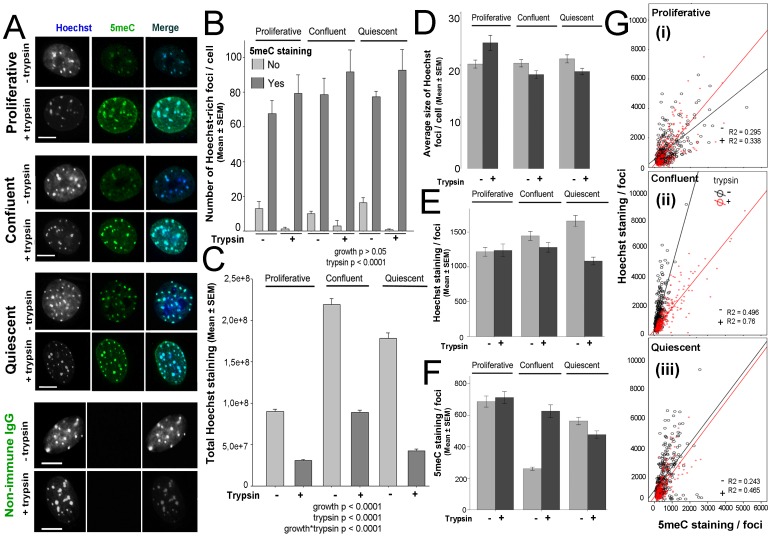
The effect of cell growth on the pattern of co-staining for 5meC and bisBenzimide (Hoechst).
A co-staining of 5meC and DNA by Hoechst in cells during proliferation after acid alone (−trypsin) or acid followed by trypsin (+trypsin). 5meC foci are co-localized with Hoechst-dense regions in each cell. Representative non-immune IgG staining in proliferative cells is also shown. Scale bar 10 µm. B The number of Hoechst-dense foci per cell co-stained with 5meC or failed to co-stain with trypsin (+) or without (−). Tryptic digestion significantly (p<0.0001) affected the detection of co-localization of 5meC and DNA-dense areas. C The level of Hoechst staining (arbitrary units of optical density) of cells with trypsin (+) or without (−) during proliferation. Trypsin revealed a decrease in the detection of amount of Hoechst staining in each cell (p<0.0001) and cell growth affected Hoechst staining (p<0.0001). D Average size of Hoechst-rich foci per cell (arbitrary units of optical density). E The level of Hoechst foci staining per cell. F The level of 5meC foci staining per cell. Trypsin decreased the detectable amount of Hoechst and 5meC foci (p<0.0001). Cell growth affected the 5meC (p<0.0001) but not Hoechst (p>0.05). G The relationship between Hoechst and 5meC foci staining for each nucleus in (i) proliferative, (ii) confluent and (iii) quiescent cells (p<0.0001). Hoechst and 5meC are positively correlated in each growth. R-squared for each growth is given. The results are of three independent replicates.